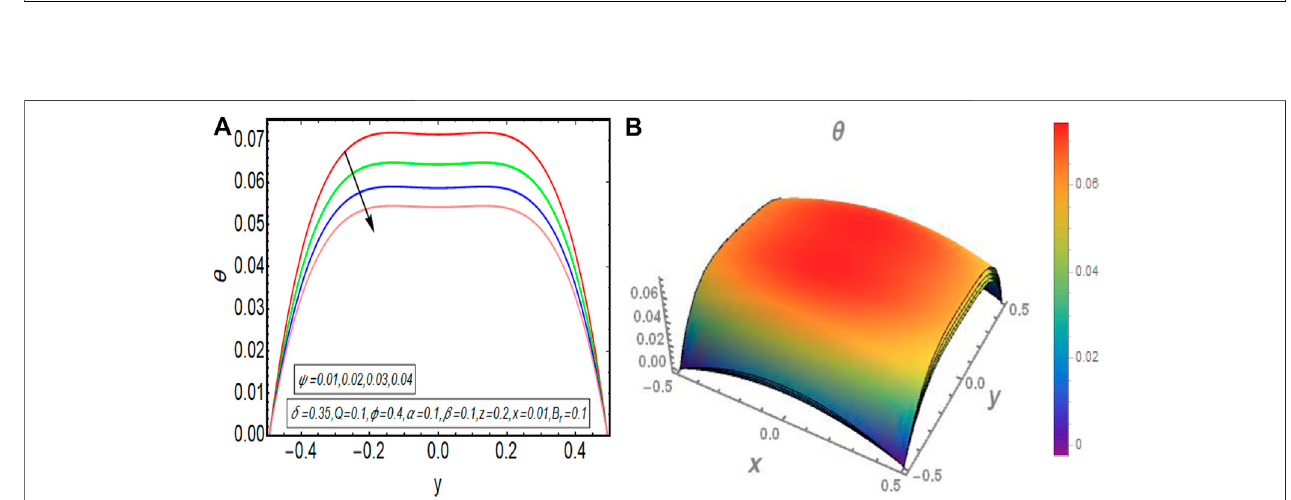
FIGURE 6 | (A) 2D-Temperature plot for flowrate . (B) 3D-Temperature plot for flowrate .